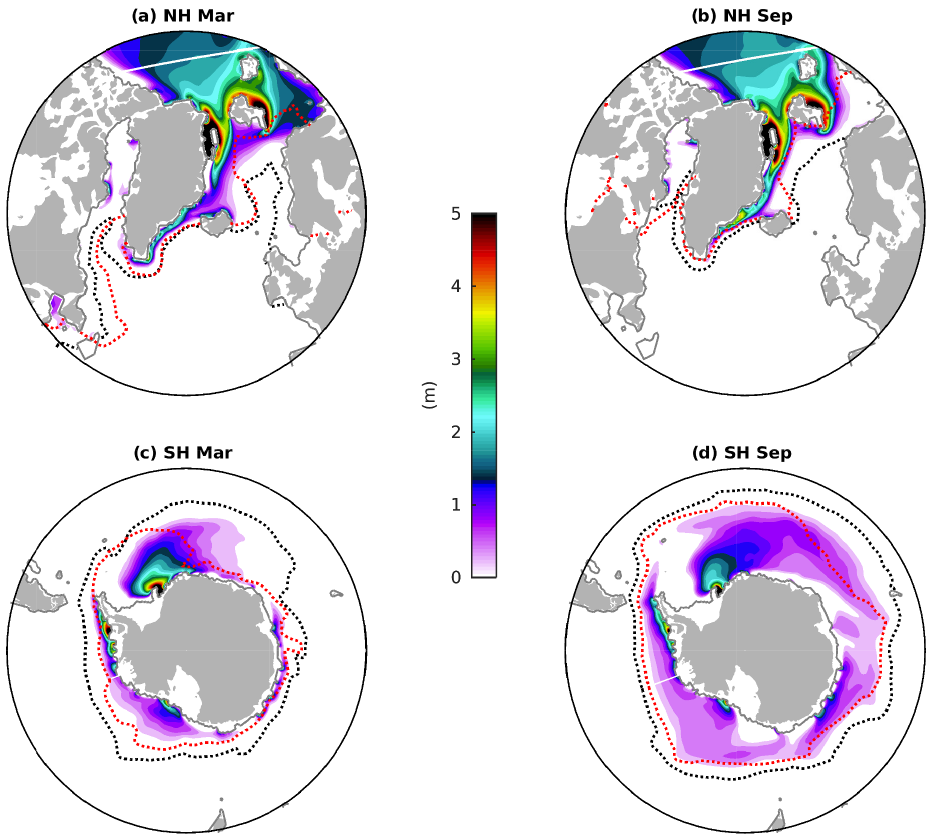
Figure 9. Simulated MIS3 – PI sea ice thickness anomalies (shading; m) for (a) NH March, (b) NH September, (c) SH March, and (d) SH September. Black and red dashed lines denote the 15% sea ice concentration for MIS3 and PI, respectively. The grey line marks the MIS3